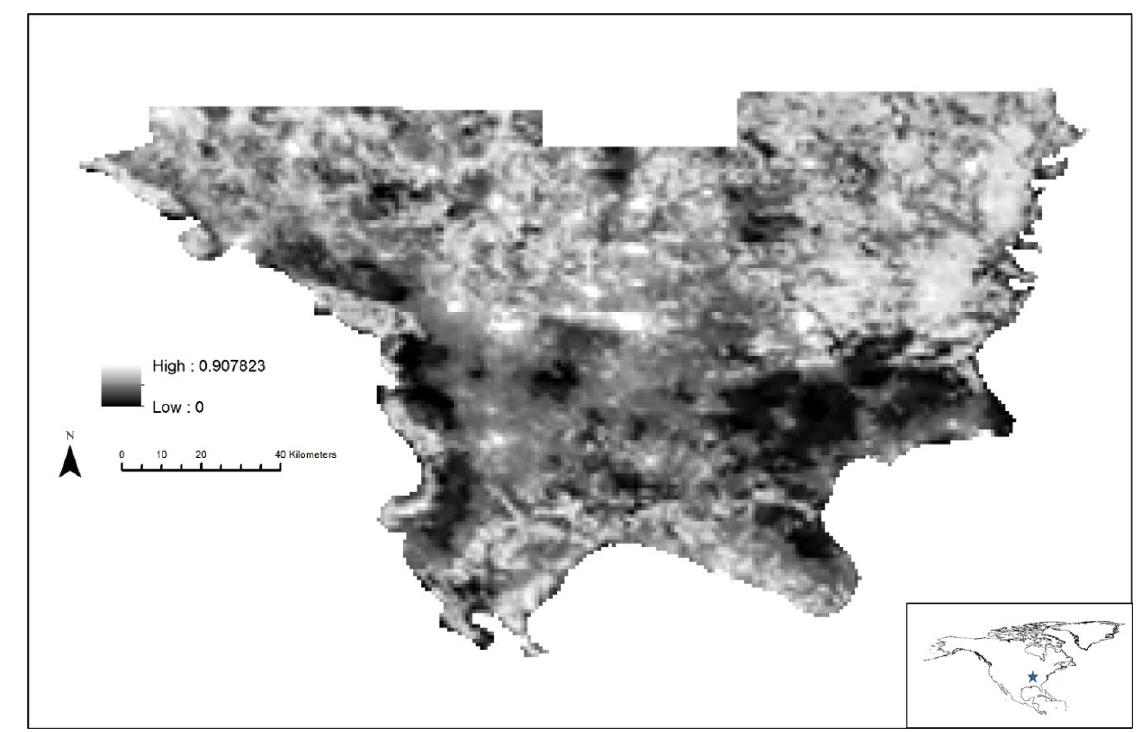
Figure 1. Human modification of southern Illinois, USA [41]. Modification score ranges from 0.0 (low) to 0.908 (high).